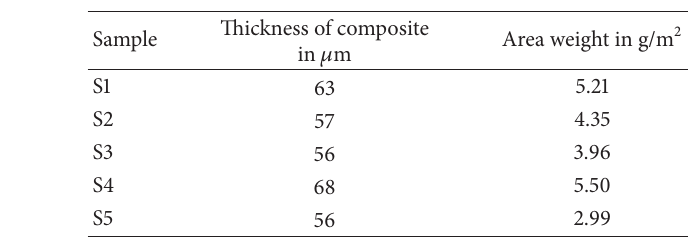
Table 2: Area weight of nanofibres and the thickness of the nanofi- bre composite